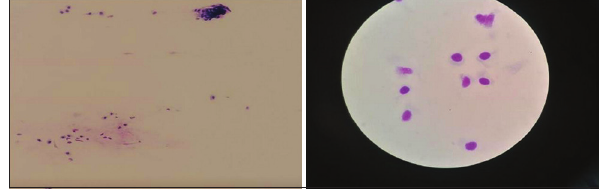
Figure-4: Mini brush cytology sample-to the left 20× magnification, to the right 100× magnification.